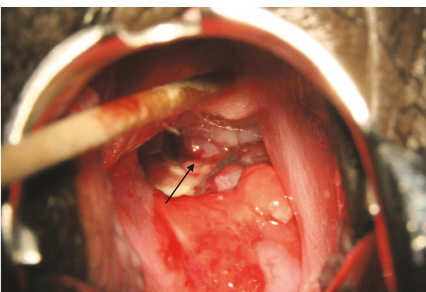
Figure 1: A view of the tumor (arrow) at initial speculum examina- tion prior to excision with cervix not visualized because the tumor was in the way.